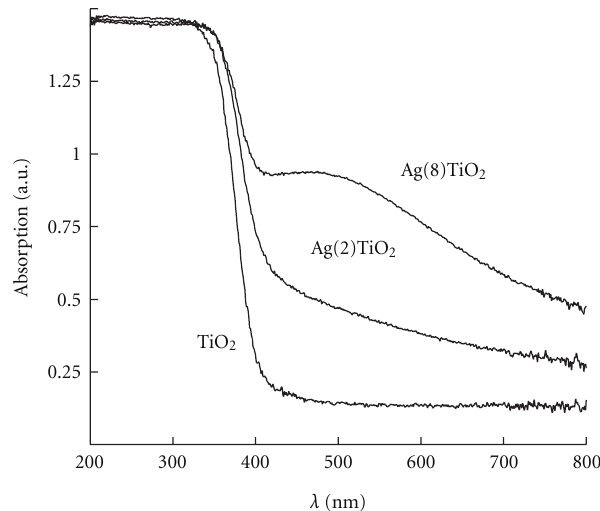
Figure 1: DRS spectra of the TiO 2 and Ag-TiO 2